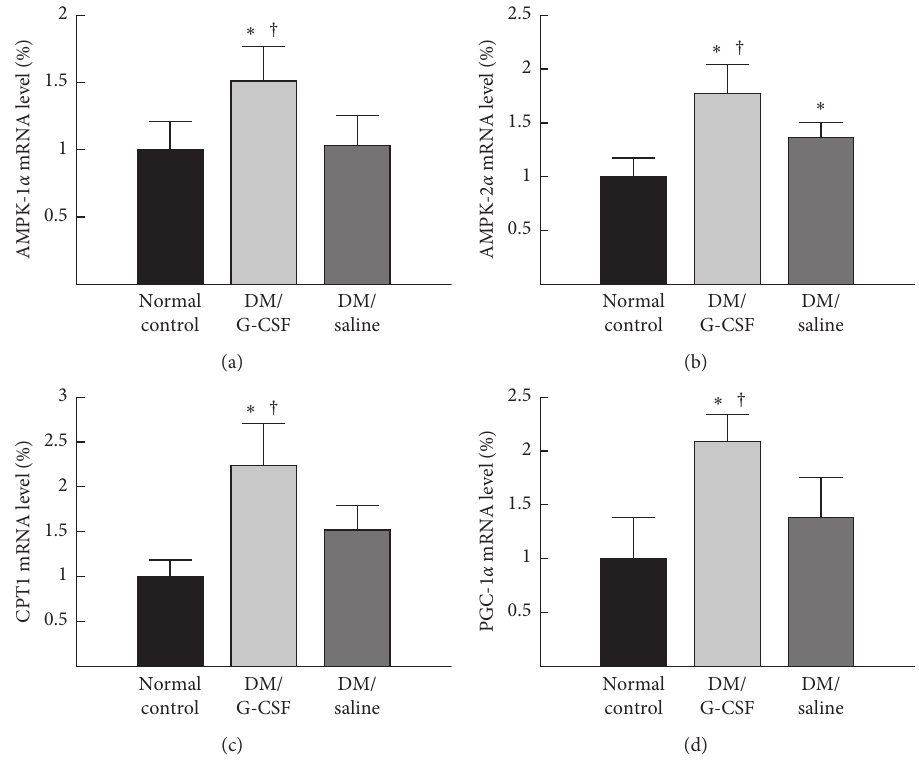
Figure 5: mRNA expression levels of β -oxidation-related genes in the rat liver . mRNA expression of AMP-activated protein kinase (AMPK)-1 α (a), AMPK-2 α (b), carnitine palmitoyltransferase (CPT)1 (c), and the peroxisome proliferator-activated receptor gamma coactivator (PGC)-1 α (d) was measured by quantitative real-time polymerase chain reaction (q-PCR) in duplicate. The transcript levels were normalized by comparison with glyceraldehyde-3-phosphate dehydrogenase (GAPDH) expression. DM, diabetes mellitus. All data are expressed as the means ± standard deviations ( n � 8 per group). ∗ P < 0 . 05 vs. normal control. † P < 0 . 05 vs.